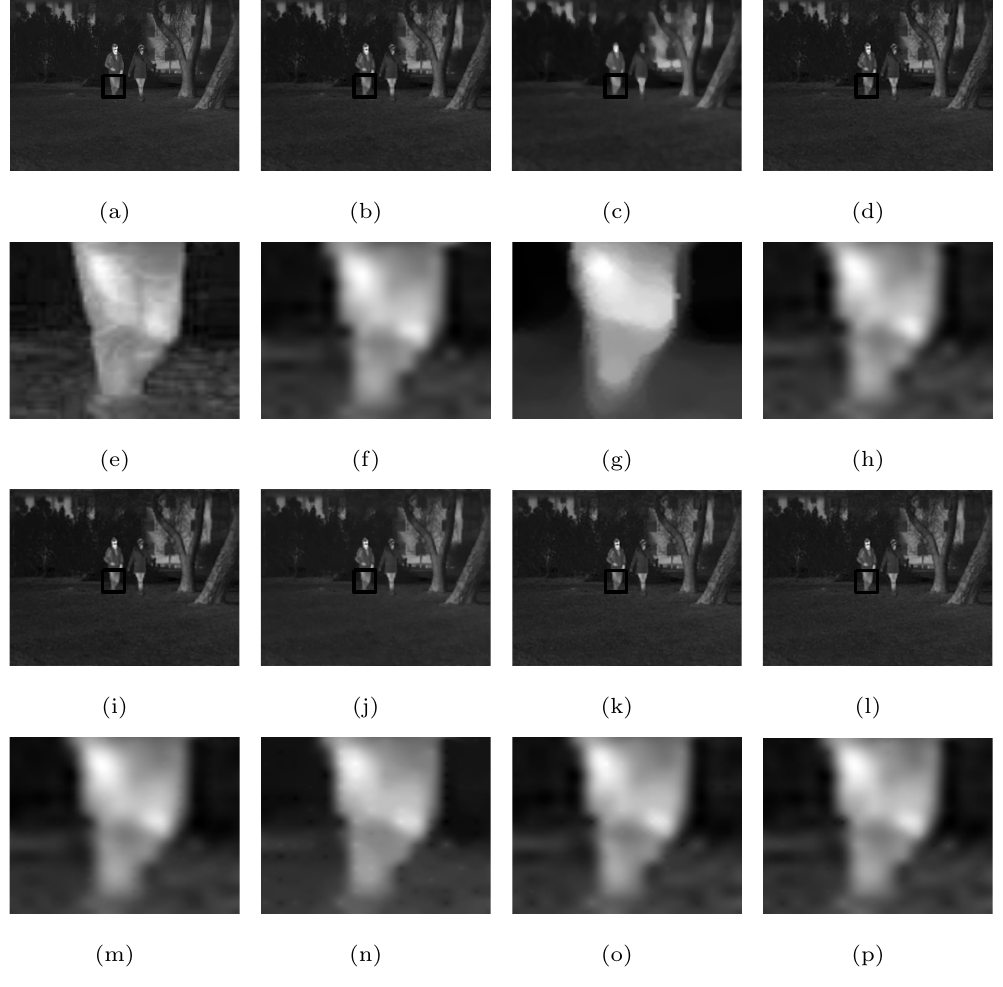
图 1: description of figure Figure 5. Super-resolution x4 results of the LR bird images without noise; ( a – d , i – l ) ground truth and the results of the Bicubic, MFT, TV, TGV, TV4, FTV4, and FTV4Lp methods, respectively; ( e – h , m – p ) enlarged details from the rectangles in ( a – d , i – l ),